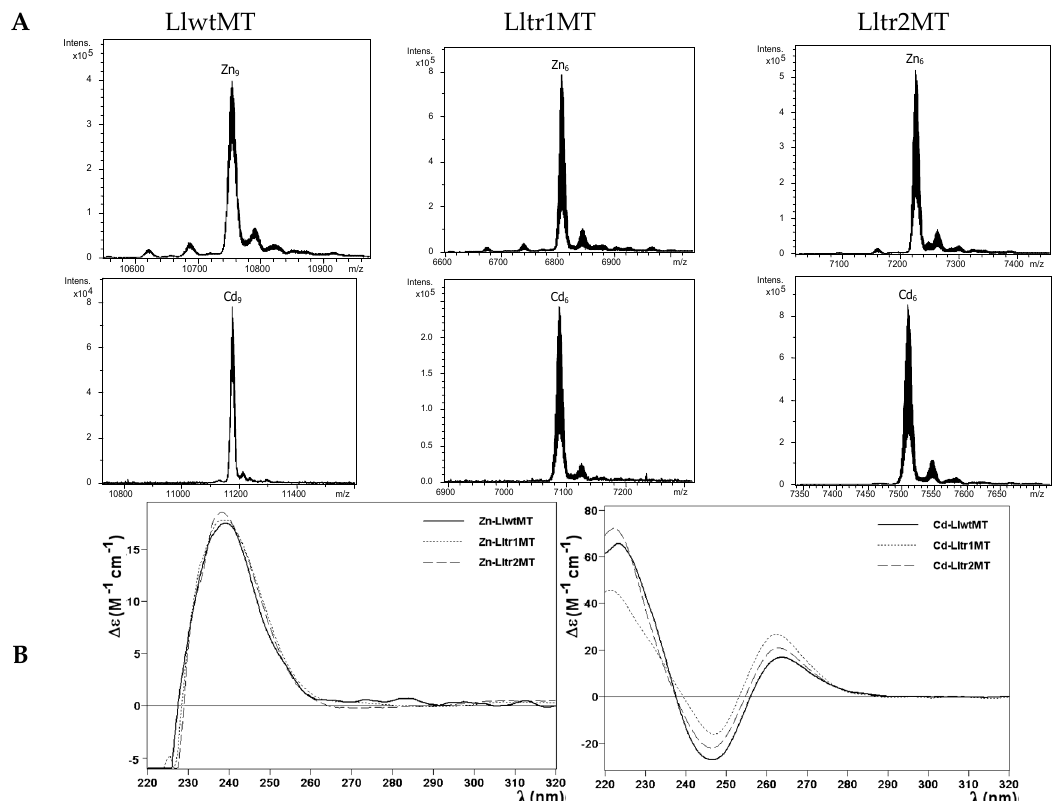
Figure 4. Analysis of the Zn- and Cd-LlwtMT, -Lltr1MT, and -Lltr2MT complexes. ( A ) Deconvoluted ESI-MS spectra of the recombinant preparations of LlwtMT, Lltr1MT, and Lltr2MT, purified from Zn- and Cd-supplemented cultures, analyzed at neutral pH (7.0); ( B ) CD spectra of the corresponding Zn- and Cd-LlMT recombinant preparations.